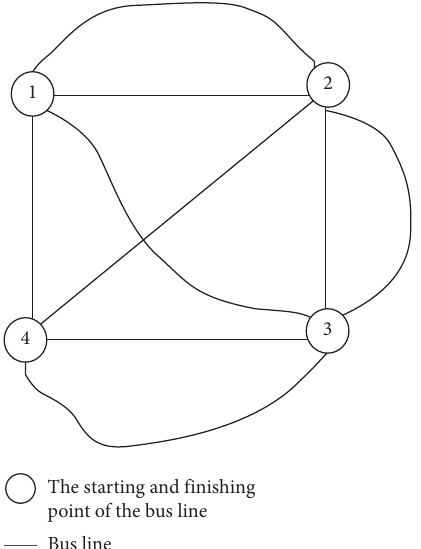
Figure 1: Schematic diagram of the line network constituted by bus